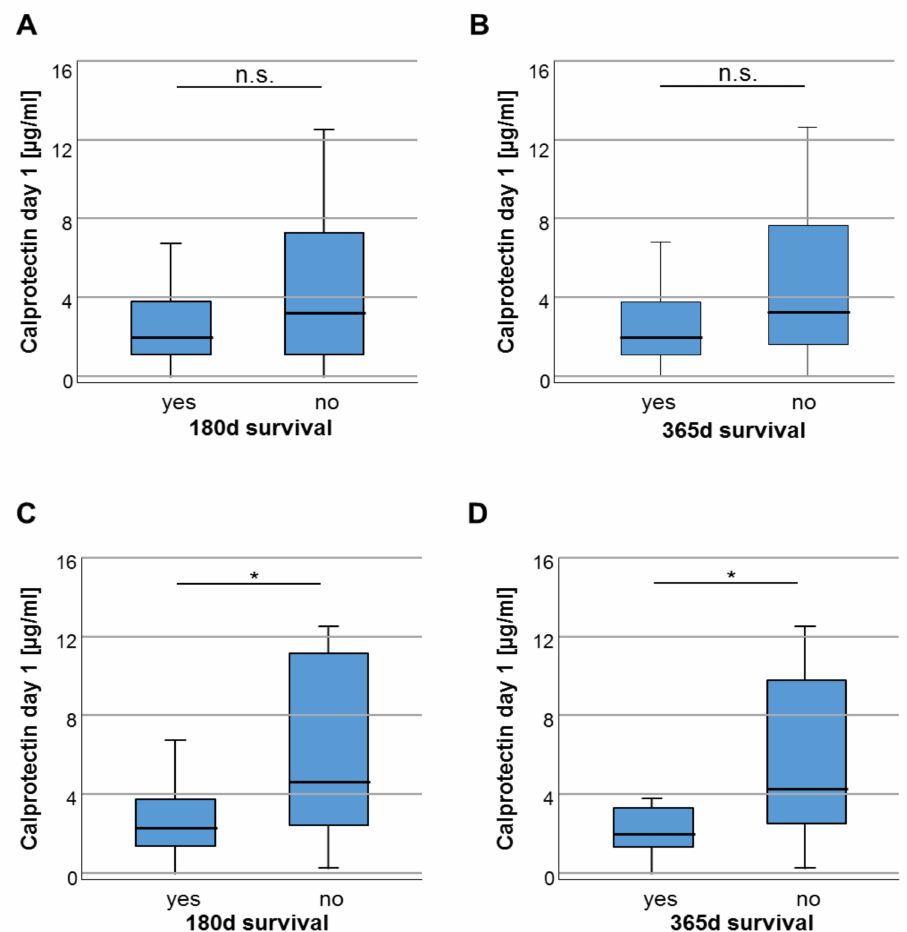
Figure 2. High baseline calprotectin concentrations predict poor 180 and 365 days outcome in septic patients. The subfigures ( A , B ) include the whole cohort of critically ill patients whereas subfigures ( C , D ) are based on subcohort data of patients admitted to the ICU due to sepsis. ( A ) Critically ill patients who died 180 days or 365 days after ICU admission show a trend towards higher calprotectin serum concentrations ( p = 0.104 for 180 d; A; p = 0.076 for 365 d, B). ( C , D ) Septic patients who deceased